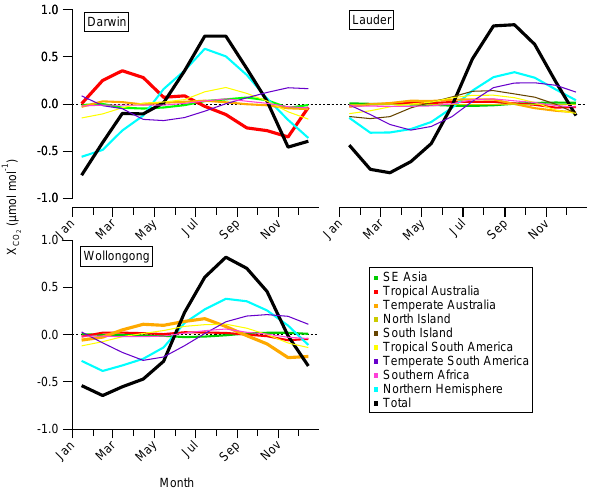
Figure 7. Regional decomposition of the mean seasonal cycles of biomass burning in the TM3 simulation with CT2011_oi fluxes.